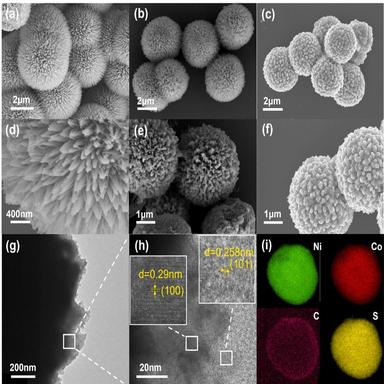
SEM images of CoNi-MOF (a and d), CoNi@C (b and e), and Co0.11Ni0.89S@NC (c and f); TEM images (g) and HRTEM image (h) of Co0.11Ni0.89S@NC; Elemental mapping (i) of Co0.11Ni0.89S@NC.